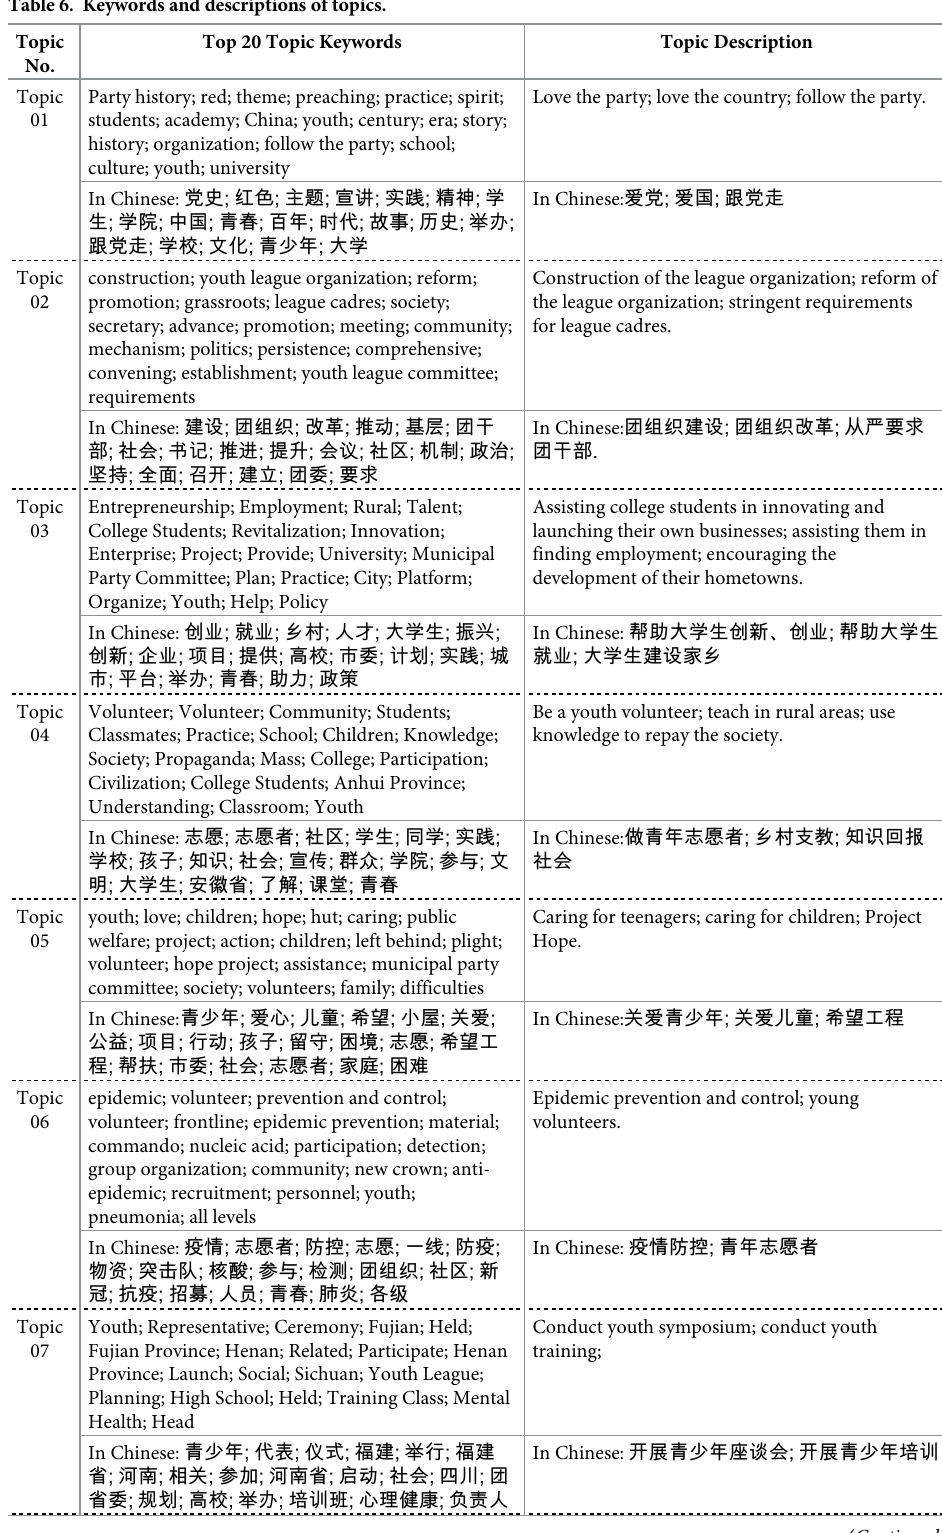
Table 6. Keywords and descriptions of topics. Topic